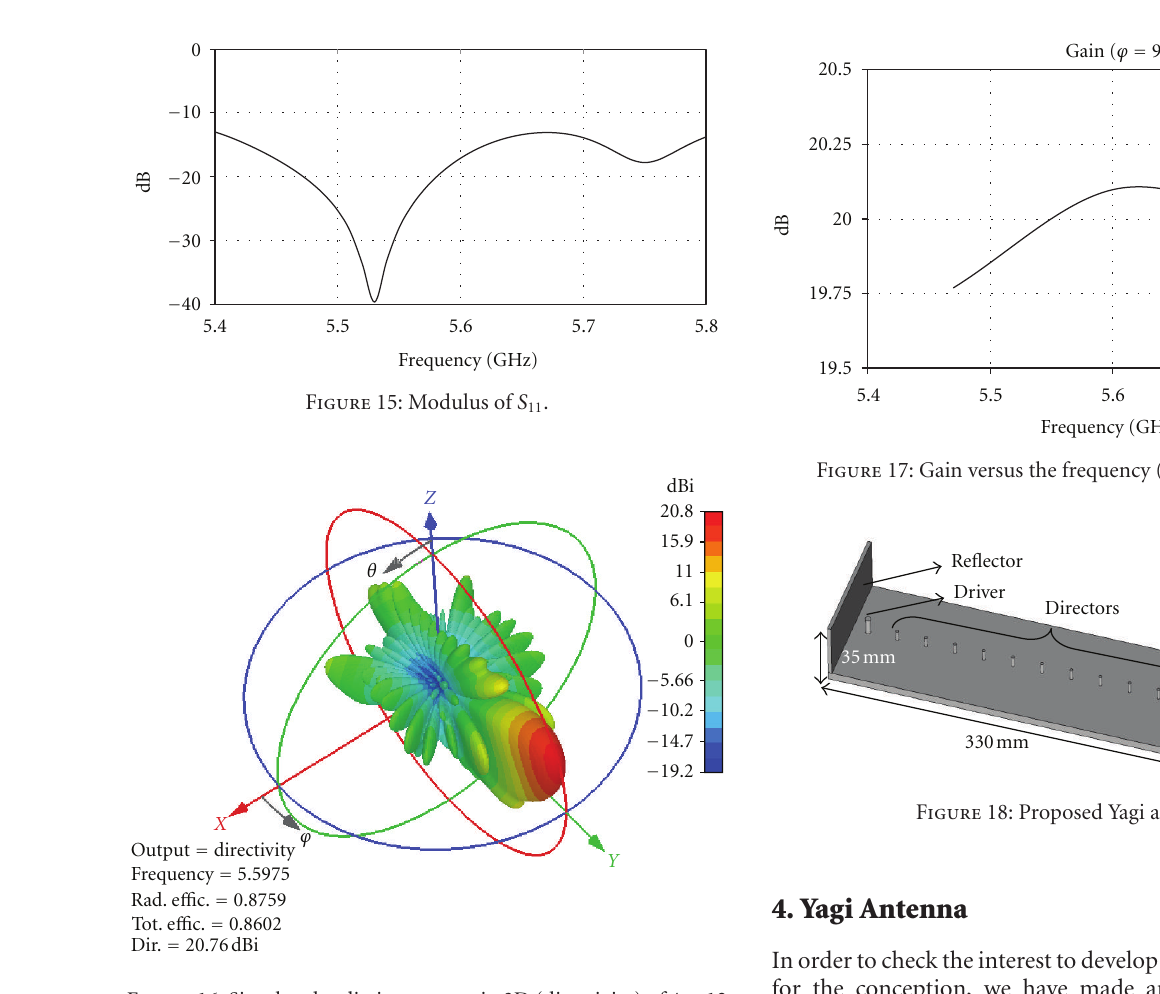
Figure 16: Simulated radiation pattern in 3D (directivity) of 4 × 12 monopoles at 5.6 GHz.